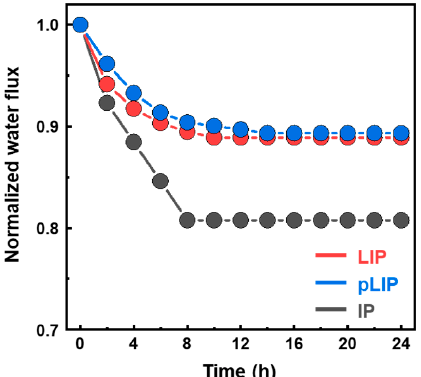
Figure 7. Water flux normalized by the initial value of the LIP, pLIP, and conventional IP membranes upon the addition of BSA to the DI water feed for 24 of RO operation.